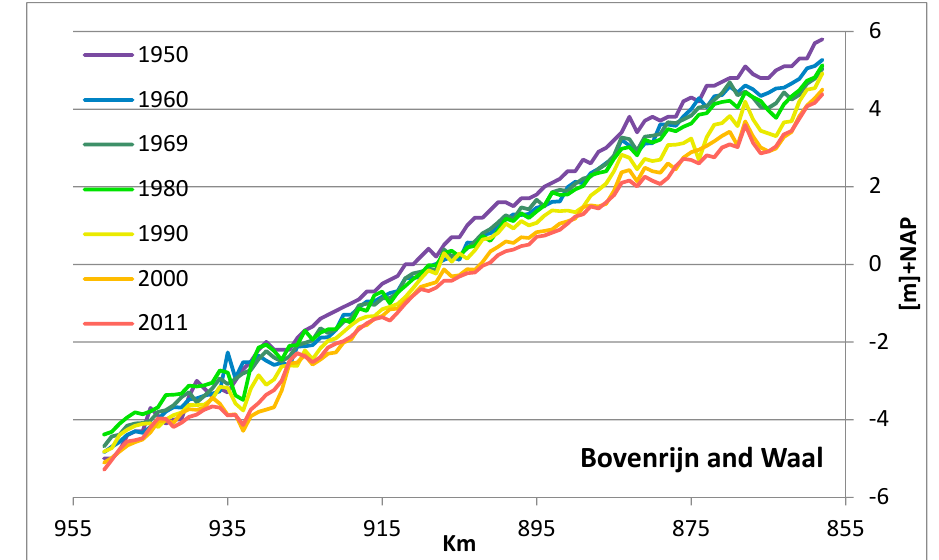
Figure 6. Average bed levels in Waal and Bovenrijn rivers between 1950 and 2011 (copyright RWS).